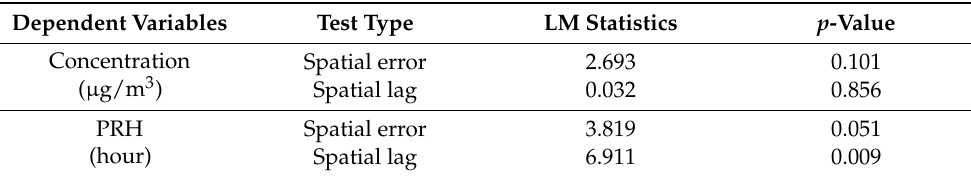
Figure 3. Spatial autocorrelation of the OLS residuals of ( a ) hourly mean PM 2.5 concentration and ( b ) PRH. Table 3. Results of the LM tests.